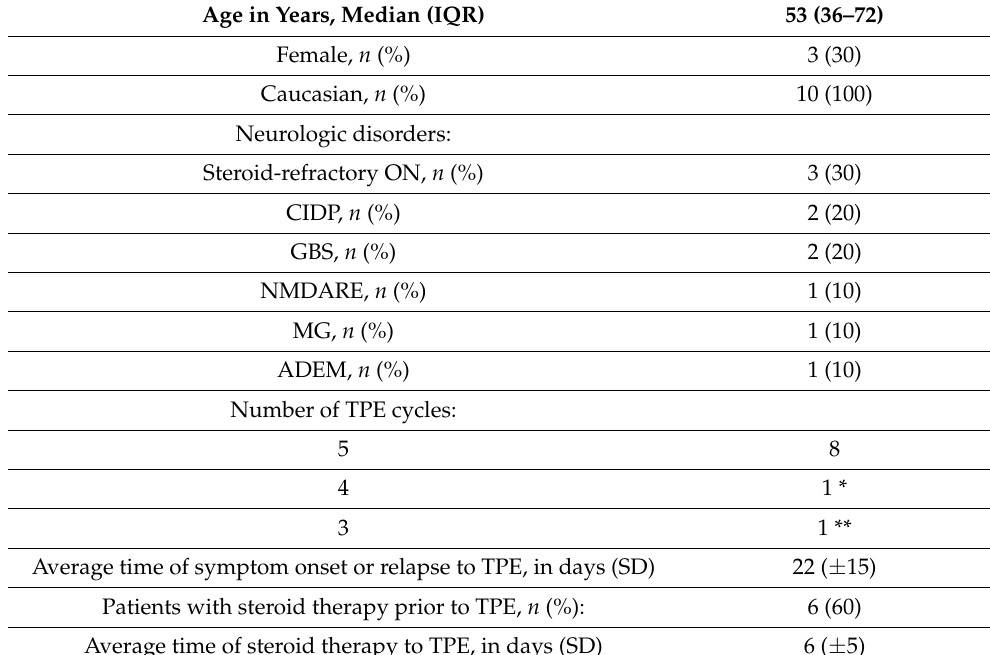
Table 1. Patient characteristics ( n =